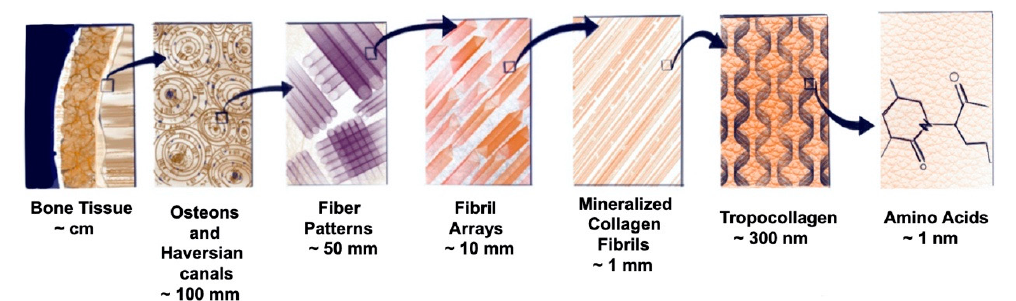
Figure 4. Macro- and microstructural arrangement of bone: the macroscale structure comprises of dense outer compact bone and spongy inner cancellous bone. Compact bone is arranged into osteons that form haversian canals. These osteons are formed by fibres arranged in geometrical patterns. These fibres are made up of collagen fibrils which have alternating organic phases to form fibril arrays. Each array makes up one collagen fibre. Collagen consists of protein molecules (tropocollagen) formed from three chains of amino acids. Image adapted from Launey et al. [135].